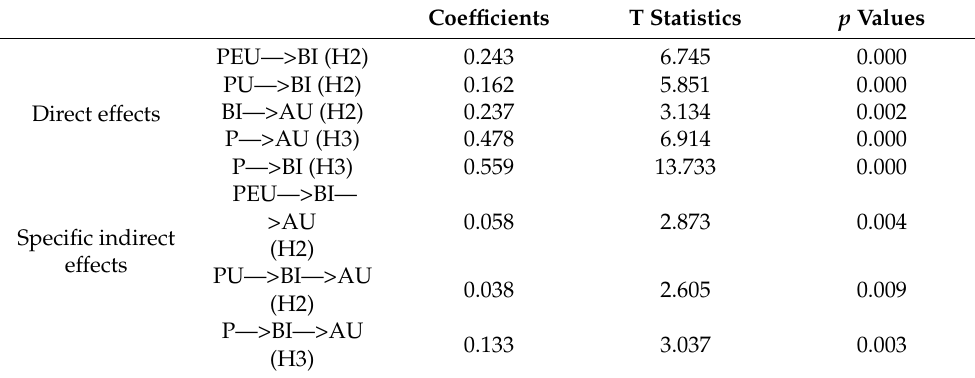
Table 6. Path coefficients.